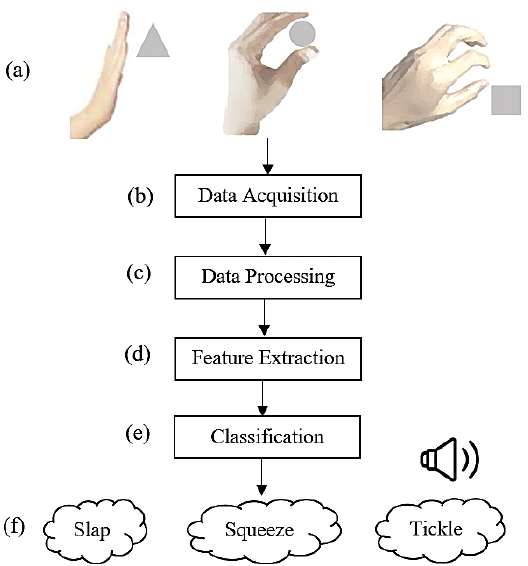
Figure 1. Touch gestures used for the classification in this study are Slap, Squeeze, and Tickle, as these are the most common actions that humans would perform in order to feel or trigger an object; ( a ) the touch is produced by the user; ( b ) the vibration is collected by the LDT0-028K PVDF sensor; ( c ) data processing and filtering; ( d ) feature extraction; ( e ) the classification using an ML algorithm; ( f ) the recognized gesture is verbally communicated.